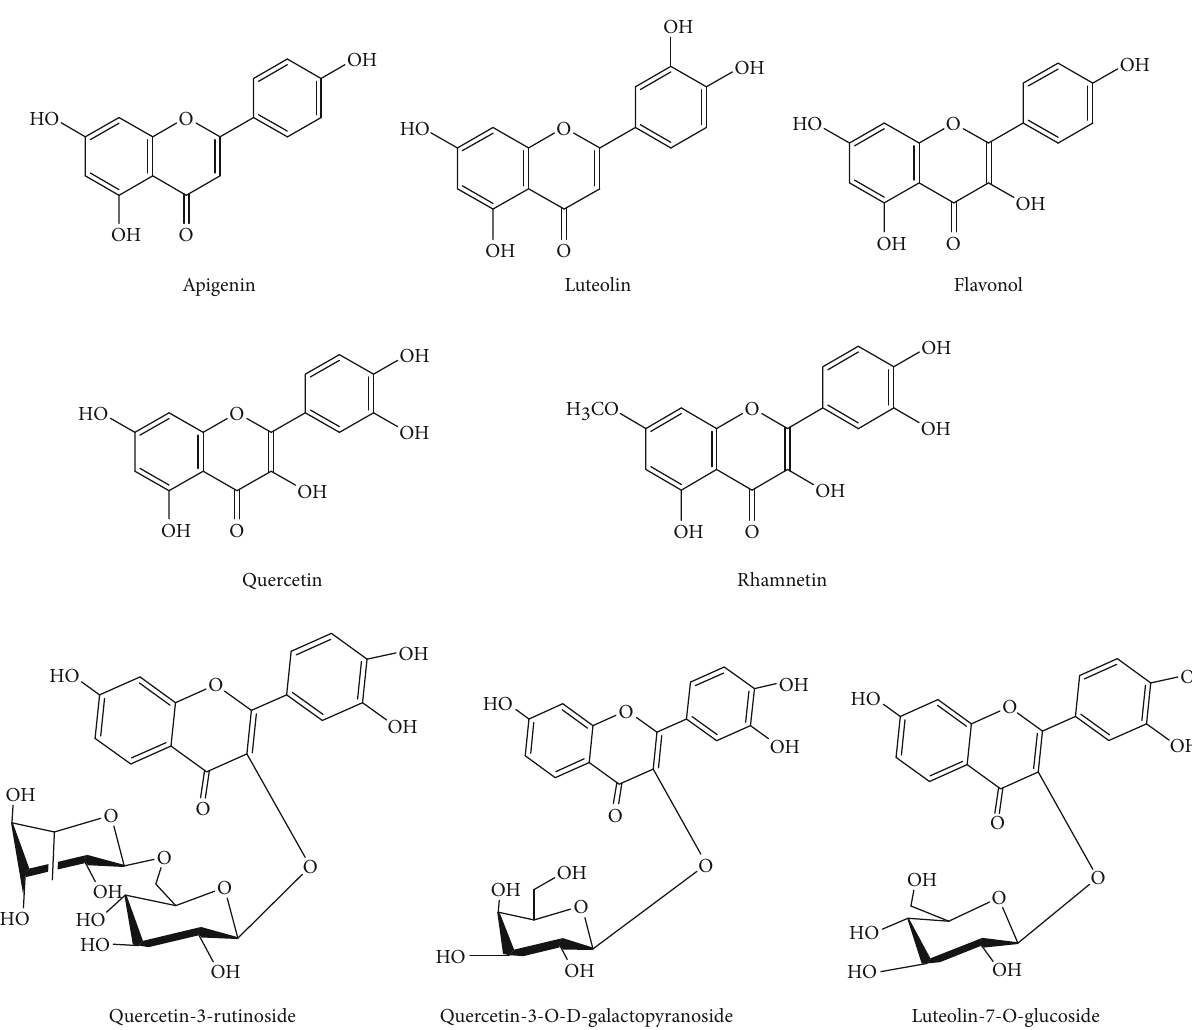
Figure 4: Structures of important fl avonoids isolated from P. lanceolata